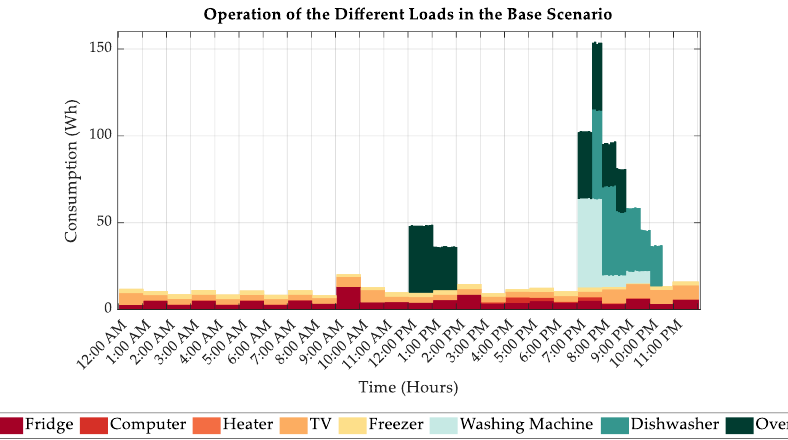
Figure 3. Base Scenario of the Chosen Day for the